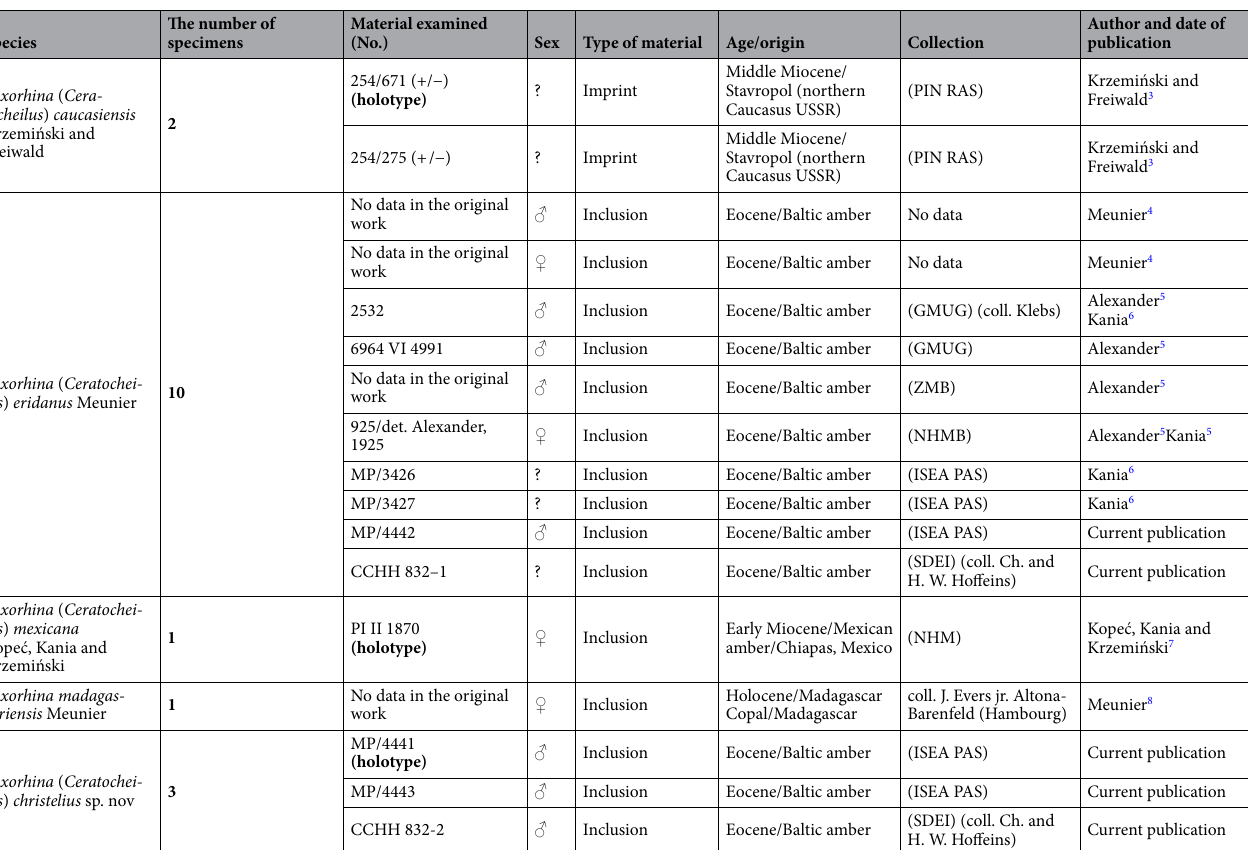
Table 2. Information about all fossil species and specimens of Toxorhina examined and described. Significant values are in